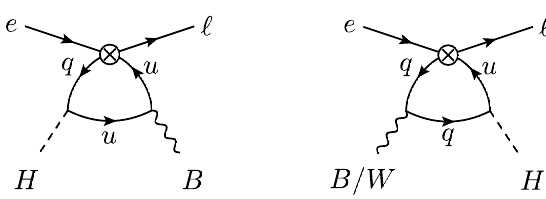
Figure 3. One-loop diagrams giving evanescent contributions to the dipole operators Q eB and Q eW